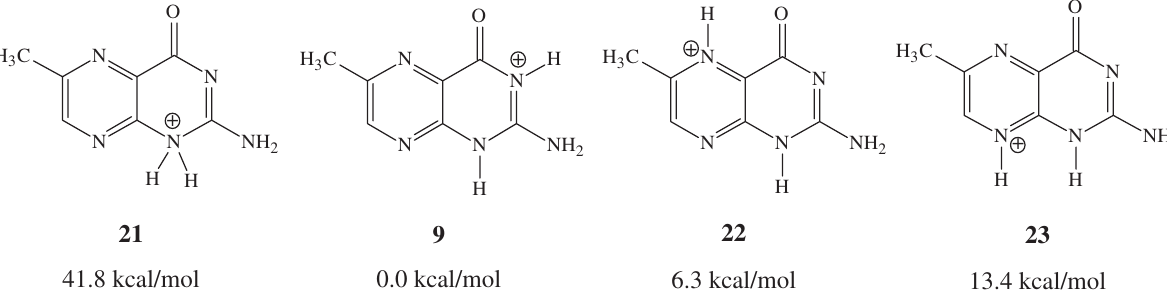
Figure 6 Relative calculated energies of pterins resulting from the ring nitrogen protonation of the α , β -unsaturated lactam structure, 4